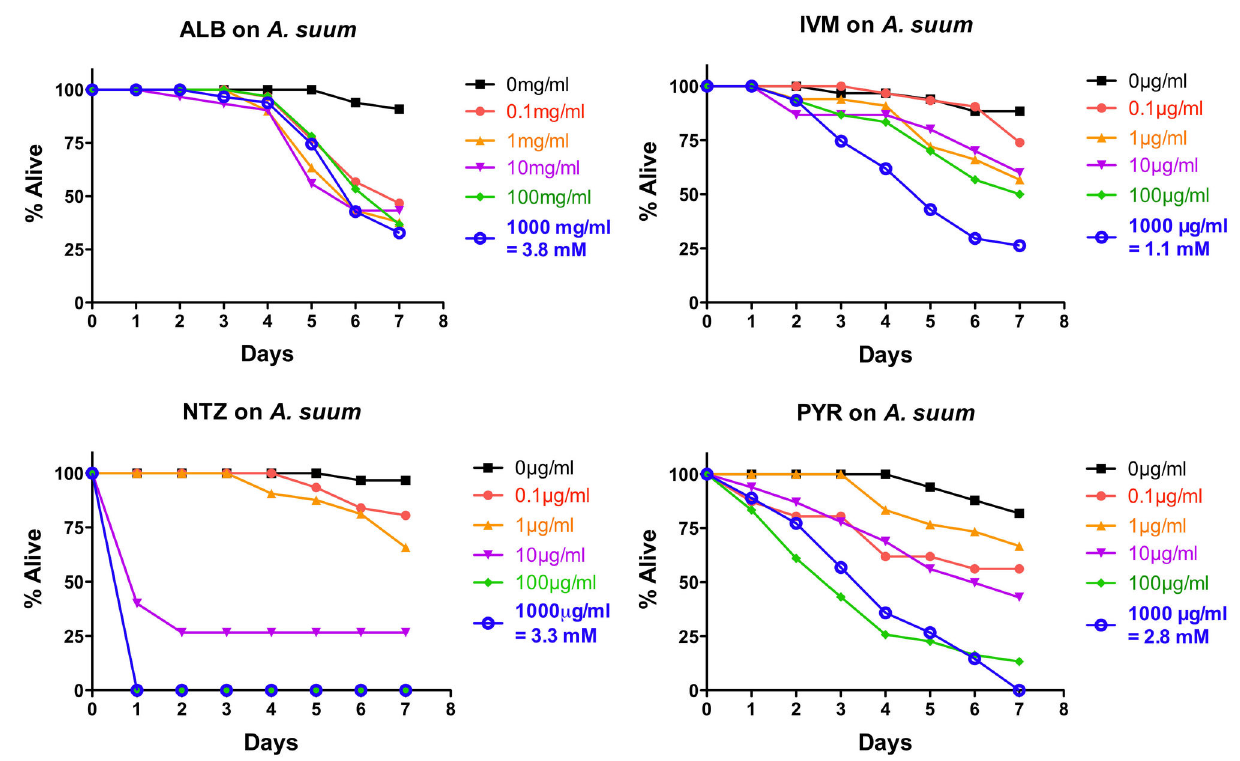
Figure 2. Intoxication of Ascaris suum fourth-stage larvae (L4) in vitro using five doses of albendazole (ALB), ivermectin (IVM), nitazoxanide (NTZ), or pyrantel (PYR). For comparative reference, the molar concentration of each drug at 1000 µg/mL is indicated. Parasites were scored daily for motility. Any motility, including motility after prodding, was counted as “alive.” Lack of motility, including lack of a response after prodding, was counted as “dead.” Data are the combination of three independent trials with 10